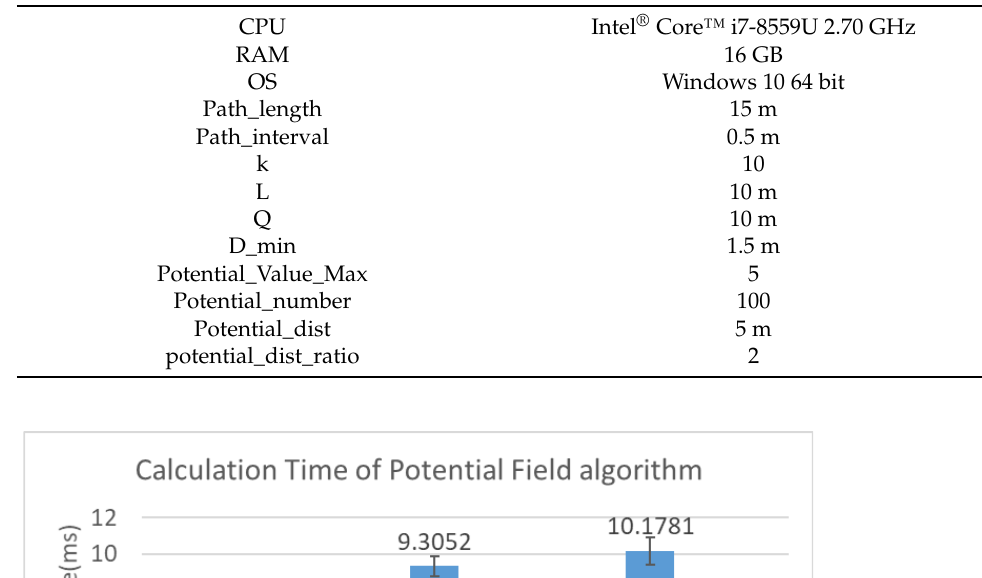
Table 2. Simulation environment.